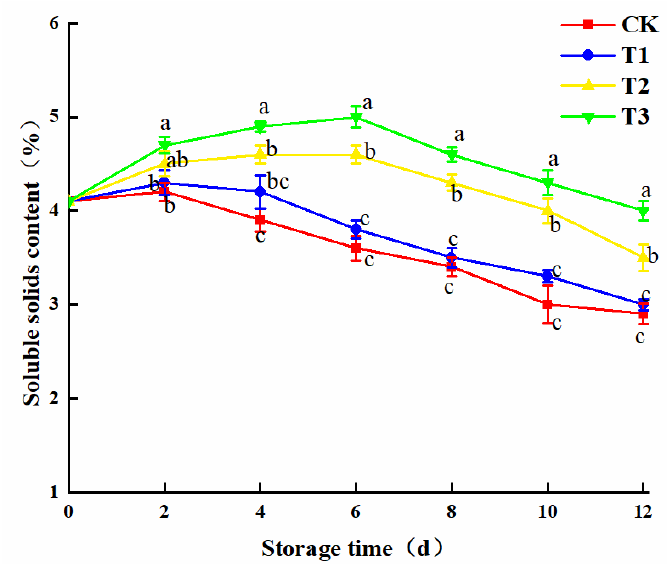
Figure 3. Changes in soluble solids content The means with different lowercase letters (a–c) in the figure differ significantly ( p < 0.05).